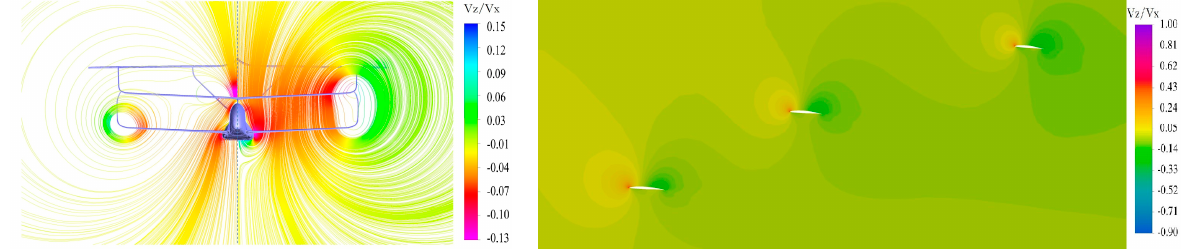
Figure 20. BWA/SL aircraft in cruise flight condition S 3 (M = 0.7 at 43,000 ft) with an angle-of-attack α = 0 ◦ . ( Left ): Flow circulation (iso-lines) and corresponding downwash effects (color code) occurring in the vertical plane passing by the first (left half) and second (right half) bent tip wing junctions (left and right half, respectively). ( Right ): downwash effects occurring in the vertical plane passing by the spanwise location b Ref/ 2.